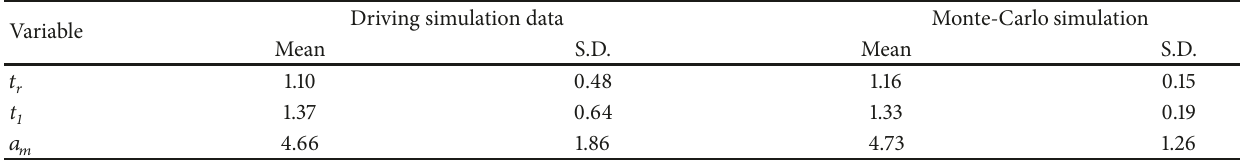
Figure 8: Distribution results of the key variables, braking response time (a), decelerationemergency control time (b), and drivers’ maximum deceleration rate (c), respectively. Table 4: Comparison results of Monte Carlo simulation and driving simulator.